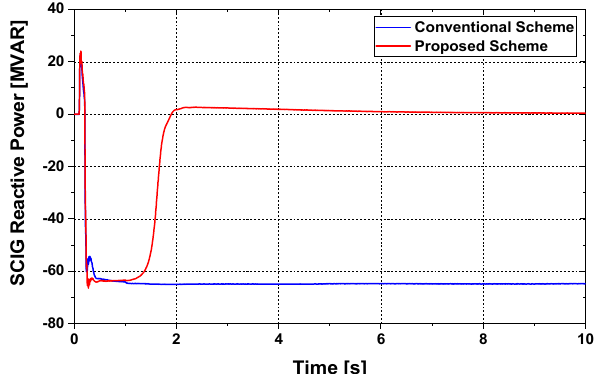
Figure 10. Reactive power response of SCIG.